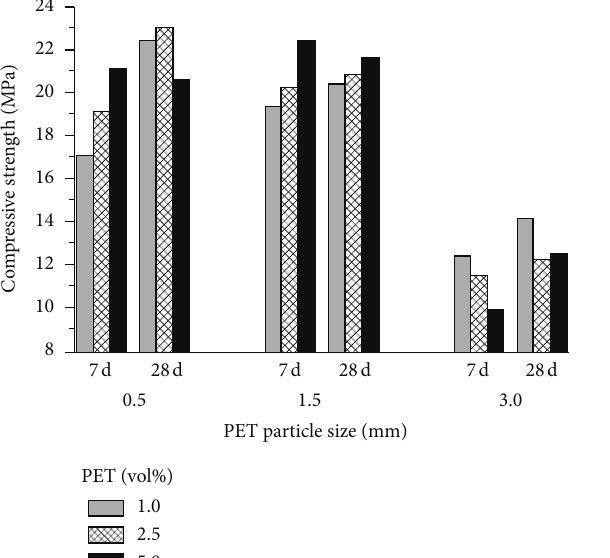
Figure 3: Compressive strain of concrete with recycled PET parti-